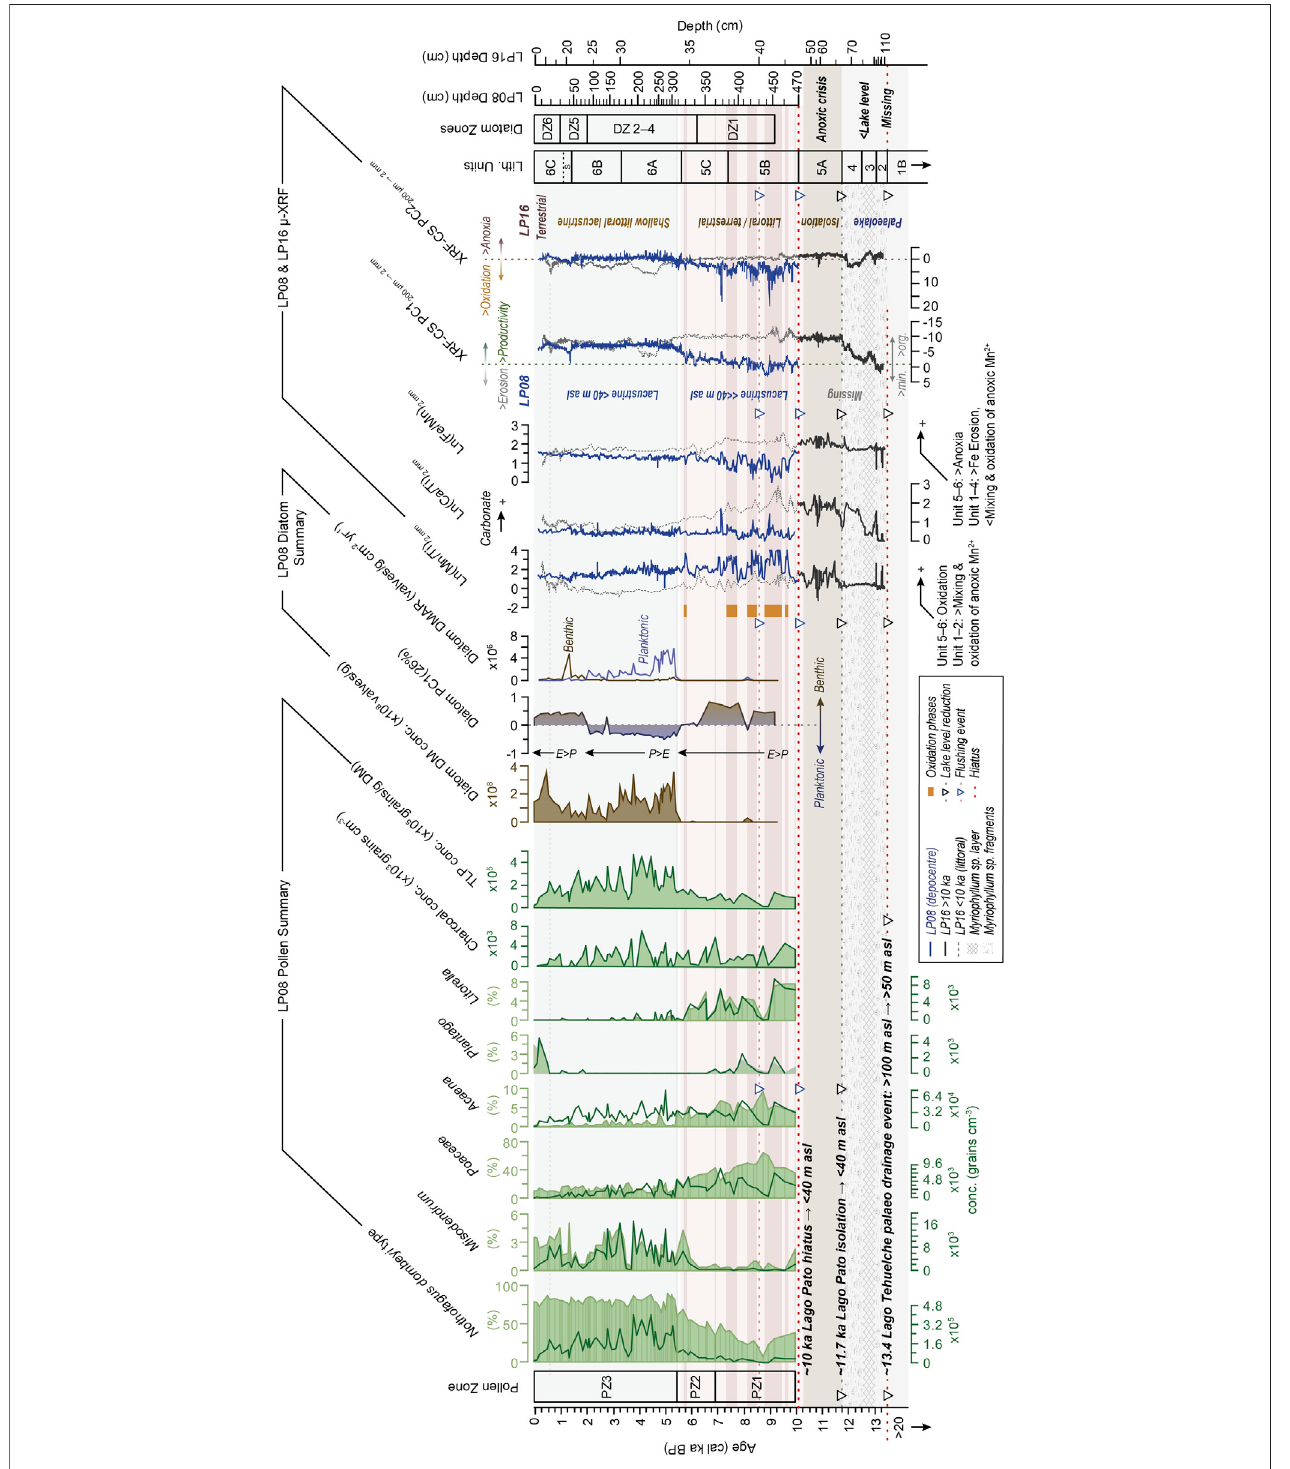
FIGURE8| SummarykeypollenanddiatomcompositionaldiagramforHolocene-age sedimentsintheLP08recordcompared tokeygeochemicallog n ratiosand principalcomponent(PC1)pro fi lesfromtheLP08andLP16recordsshownin Figures5 – 7 .DM,drymassconcentration,DMAR,drymassaccumulationrate.Datawere plotted and analysed in C2 (Juggins, 2007), with the fi nal layout achieved in Adobe Illustrator.